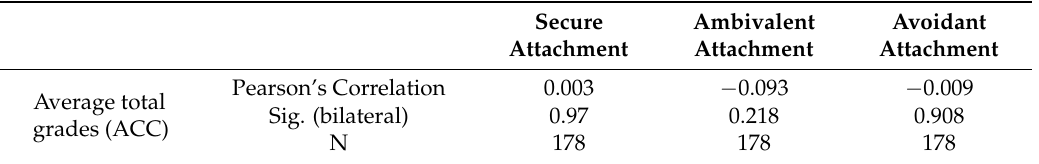
Table 6. Correlation between the subscales of the quality of childhood-attachment with the average of the total grades, in RE.